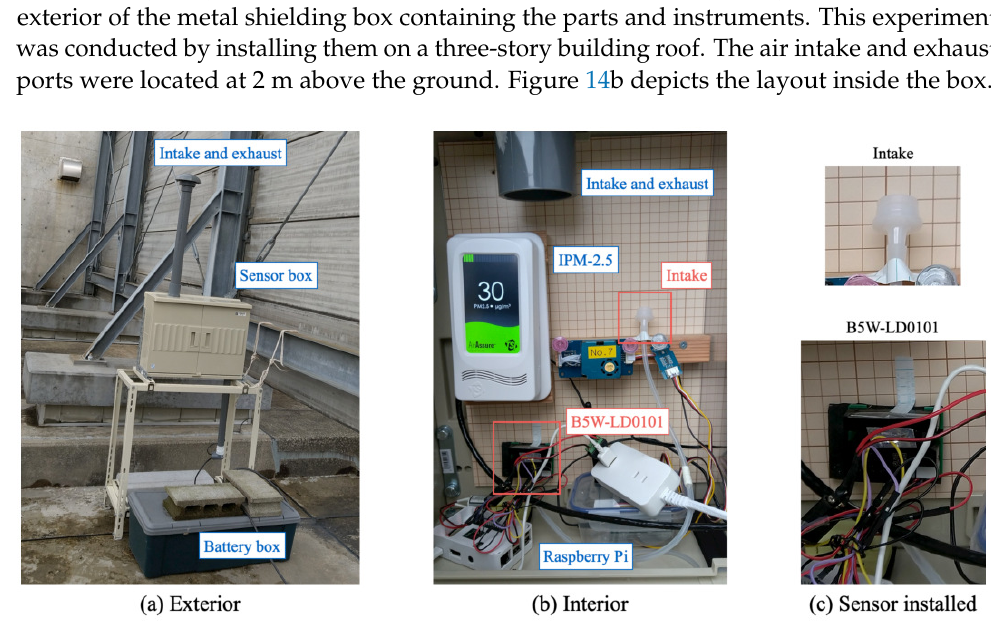
Figure 14. Originally developed benchmark measurement station installed on a three-story building roof for sensor calibration using